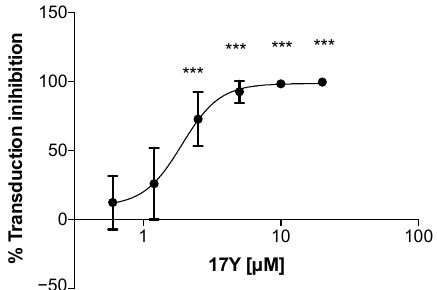
Figure 1. 17Y dose-dependent reduction in WNV RRP transduction efficiency. WNV RRPs were pre-incubated for 1 h with serial dilutions of 17Y. The mixture 17Y+RRPs was then used to transduce Vero E6 cells for 24 h. The GFP signal (normalized to the signal in the absence of the compound) was used to determine the transduction efficiency. The percentage of transduction inhibition (black dots) was calculated relative to the average of negative control (Vehicle, DMSO) to obtain a dose–response sigmoid curve. The effective concentration resulting in 50% of WNV RRP transduction inhibition (EC 50 ) was calculated to be 2.0 ± 0.4 µ M. The reported bars represent the mean ± SD from three independent experiments. Significant p -values are indicated by *** p < 0.001 measured with the one-way ANOVA test, comparing the average percentage of sample transduction inhibition with the negative control (treated with 1%